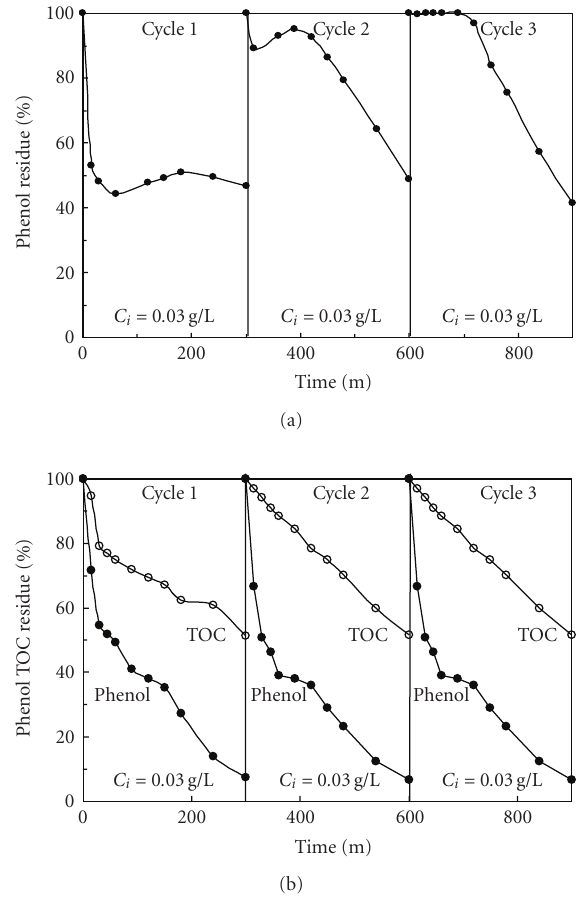
Figure 18: Cycling decomposition of phenol on immobilised